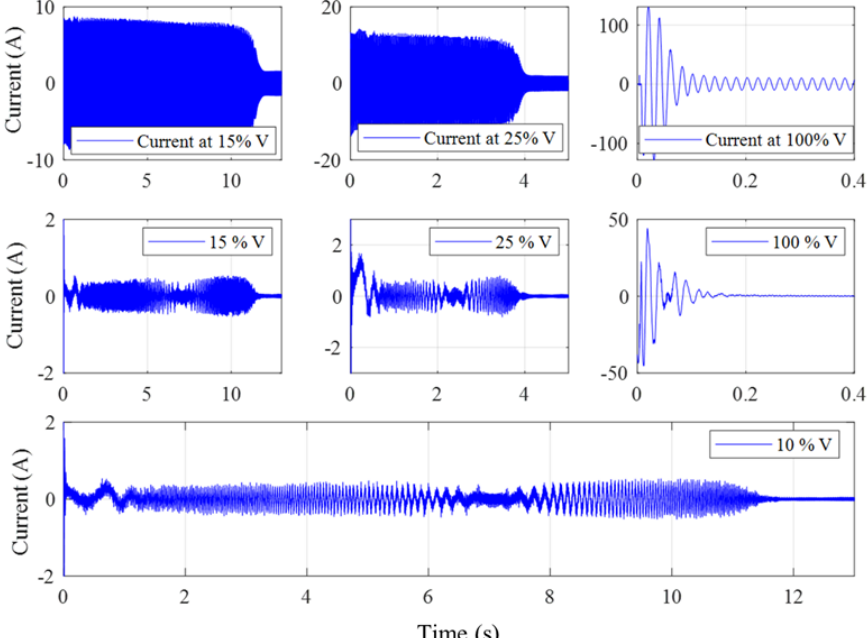
Figure 7. The motor’s startup currents measured at different voltage levels ( top row ), the corre- sponding recovered nonstationary signals ( middle row ) and the nonstationary signal at 10% of the rated voltage representing the changing frequency pattern ( bottom ).